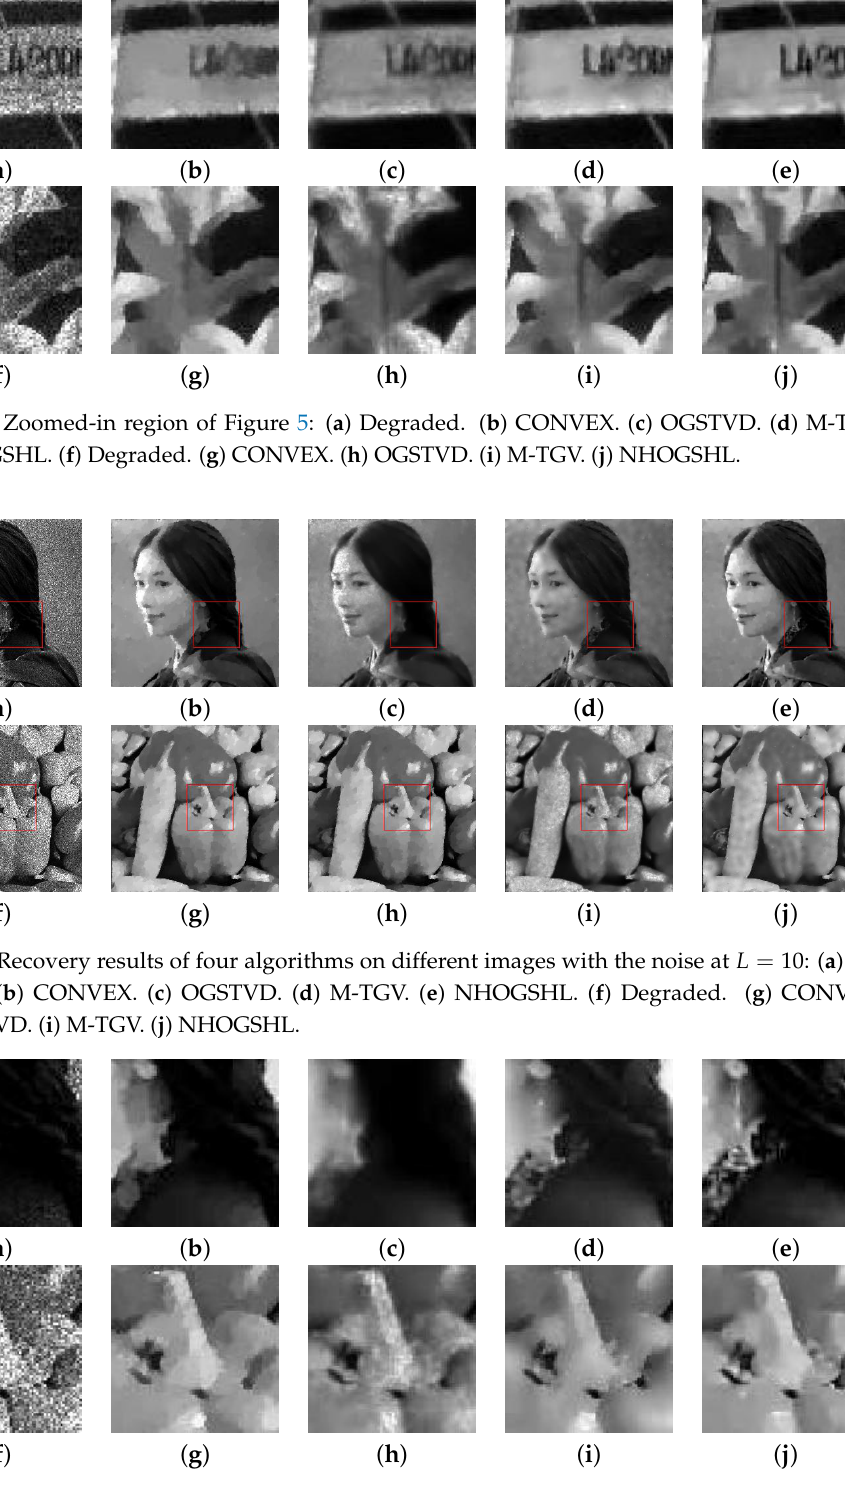
Figure 8. Zoomed-in region of Figure 7: ( a ) Degraded. ( b ) CONVEX. ( c ) OGSTVD. ( d )